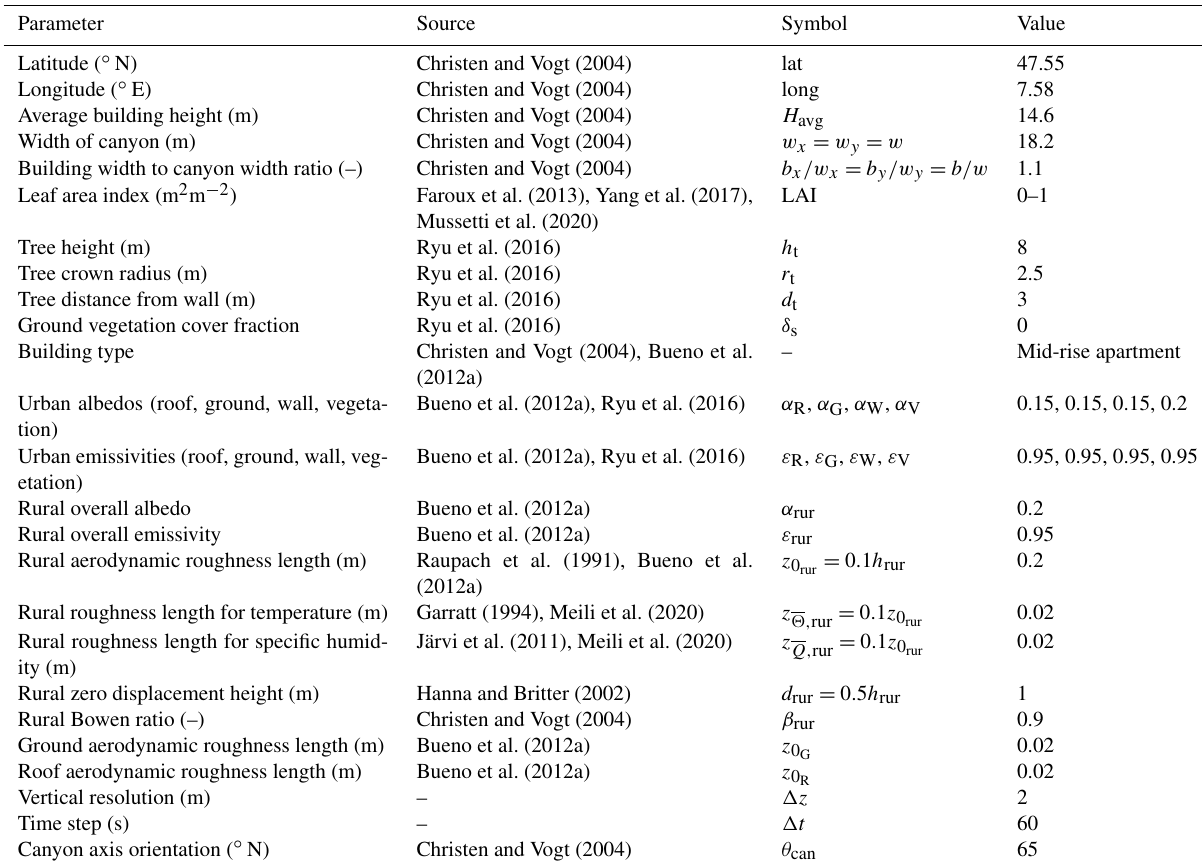
Table 1. List of input parameters used in the VCWG for model evaluation; input variables are extracted from assumptions, datasets, and simulation codes available from Raupach et al. (1991), Garratt (1994), Hanna and Britter (2002), Christen and Vogt (2004), Järvi et al. (2011), Bueno et al. (2012a), Faroux et al. (2013), Ryu et al. (2016), Yang et al. (2017), Meili et al. (2020), and Mussetti et al.